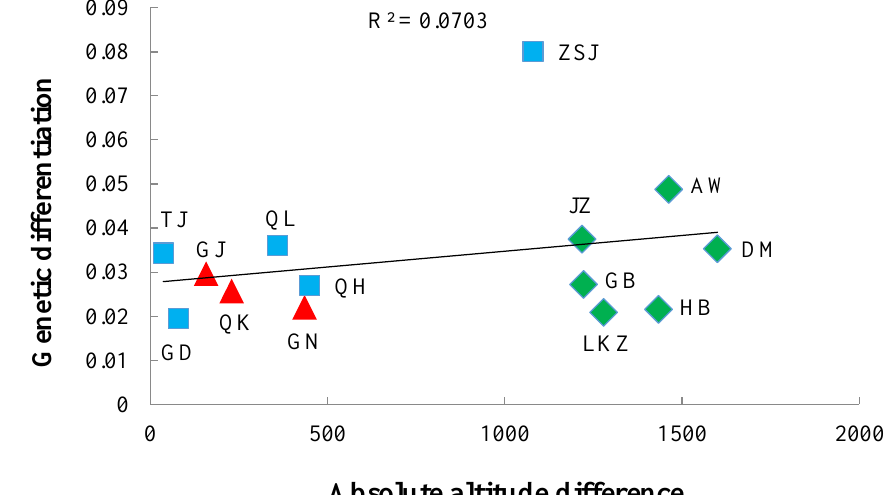
Figure 3. The genetic differentiation and absolute difference between altitudes for the population of Minxian Black Fur sheep (MX). The red triangle, blue square and green rhombus indicate that the respective samples originated from Gansu, Qinghai and Tibet province.